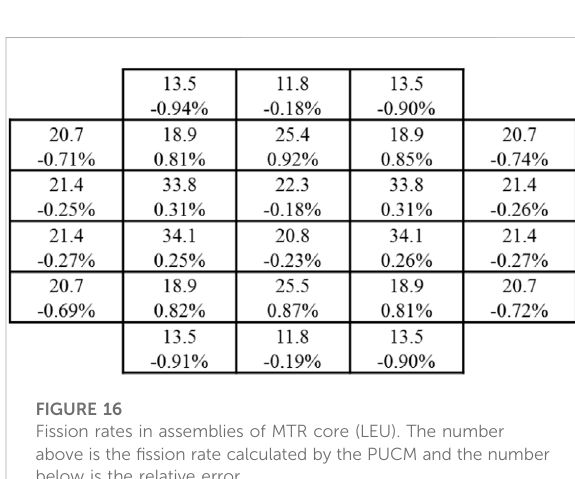
FIGURE 16 Fission rates in assemblies of MTR core (LEU). The number above is the fi ssion rate calculated by the PUCM and the number below is the relative